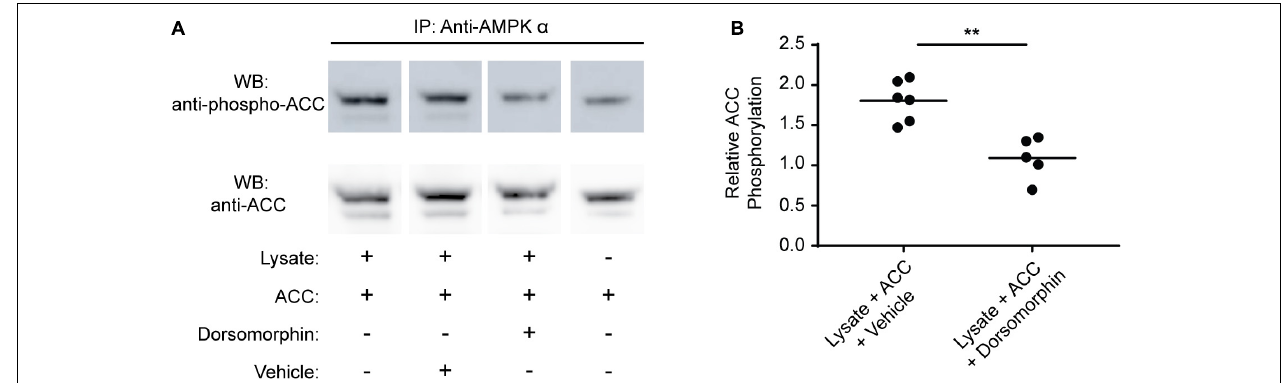
FIGURE 2 | Dorsomorphin inhibits S. mansoni AMPK α kinase activity. (A) AMPK α was immunoprecipitated from lysates of freshly isolated adult schistosomes using anti-AMPK α , then resuspended in 1 × kinase buffer with 0.2 µ g acetyl-coA-carboxylase (ACC) in either the presence or absence of 10 µ M Dorsomorphin. Control kinase assays were performed where the lysate (source of the kinase) was omitted. Kinase assay supernatants were probed by Western blot using anti-phospho ACC and anti-ACC antibodies. IP indicates antibody used for immunoprecipitation. WB indicates the antibody used for Western blotting. (B) The intensity of the anti-phospho ACC signal relative to the anti-ACC signal for each sample was determined. Each data point represents an independent kinase reaction. ** P ≤ 0.01.